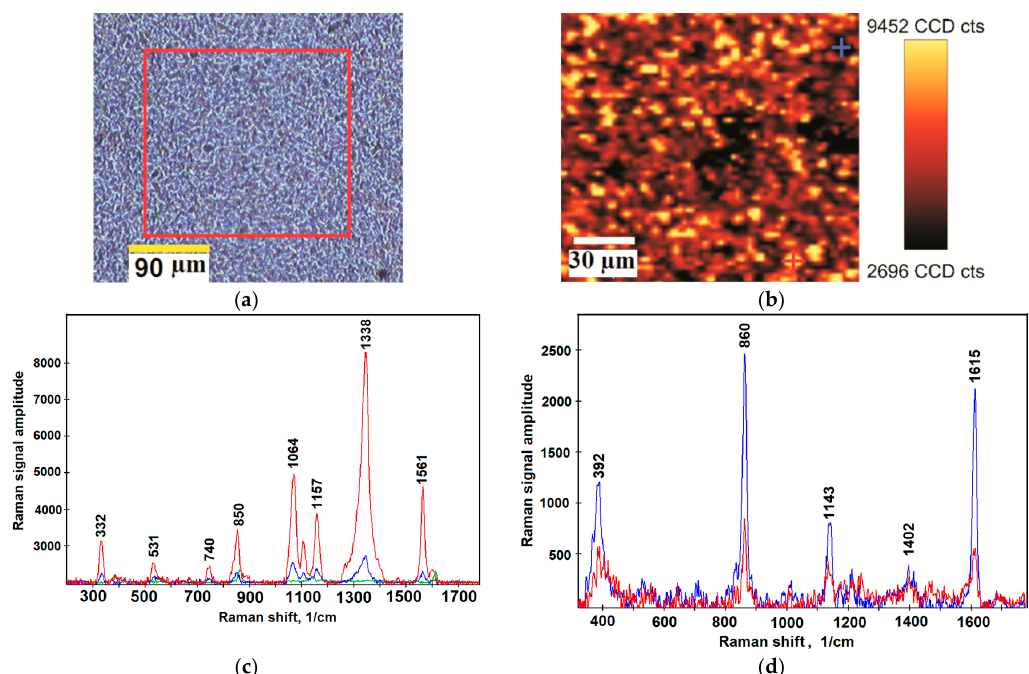
Figure 4. The results of the DTNB SERS signal investigation. ( a ) Optical image of the surface where the mapping area is shown by the red square; ( b )mapping result of samples with h 1 —300 nm, h 2 — 30 nm. The distribution of the amplitude of the main vibration band of the DTNB—1338 cm − 1 is presented in the form of a 2D map; ( с ) DTNB spectra at the brightest (red) and darkest (blue) scan points of the sample; and green—spectrum of clear substrate. The red cross in Figure 4b shows the place where at the spectrum with a higher amplitude was measured and the blue cross shows the place where at the spectrum with a lower amplitude was measured; ( d ) blue—spectrum of pure substrate, and red—spectrum after modification of the substrate with a solution of myoglobin.